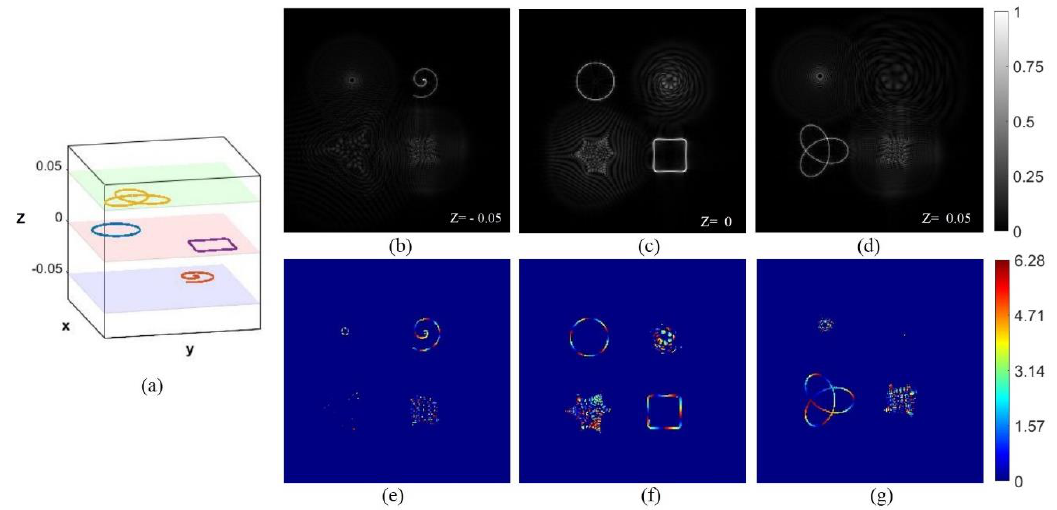
Figure 3. The beams focused on different regions. A three-dimensional schematic of focused beams is seen in ( a ). Intensity distribution of the beams projected in the focal plane (z = 0) seen in ( c ), and the Archimedean spiral and the trefoil-knotted curve are focused on the z = − 0.05 m and z = 0.05 m planes, respectively, seen in ( b , d ). ( e – g ) The phase distribution of the multiple light beams.